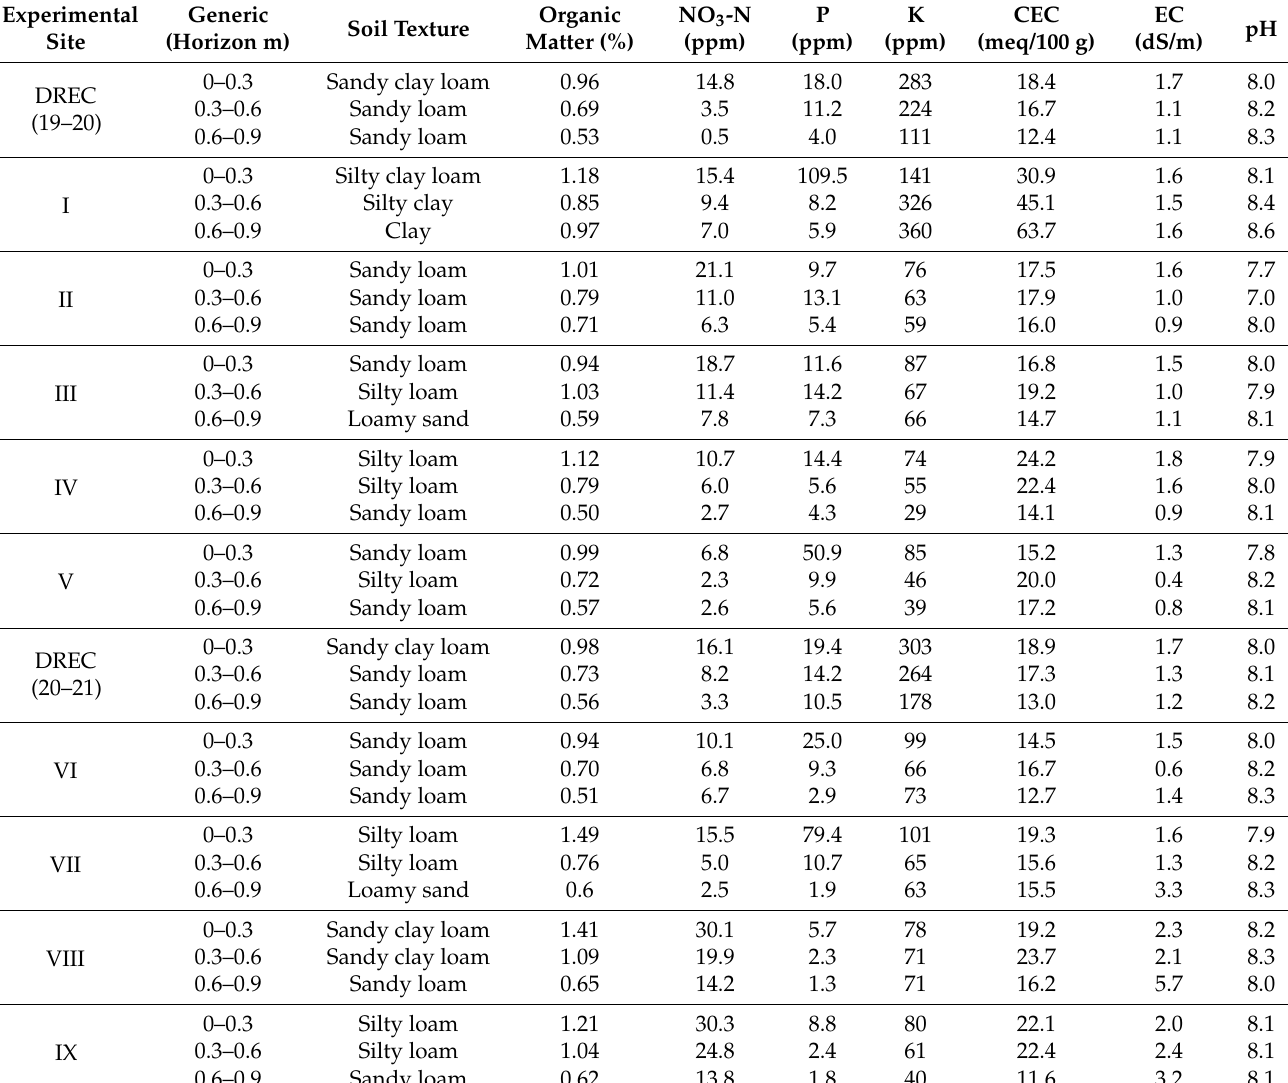
Table 2. Physical and chemical properties of the soil of the experimental sites. The data of pre-seeding are presented. Experimental